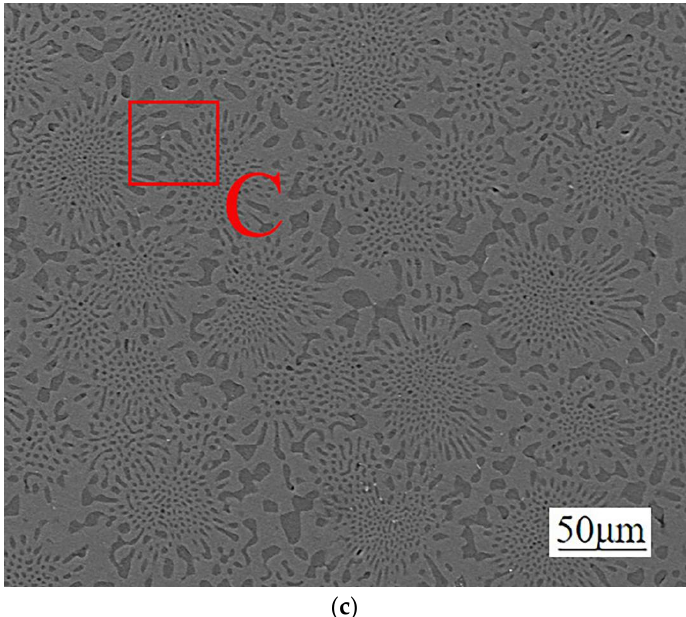
Figure 5. Cross-sectional structure of different diffusion layers: ( a ) Mg 2 Al 3 layer, ( b ) Mg 17 Al 12 layer, and ( c ) Mg 17 Al 12 and Mg-based solid solution layer.